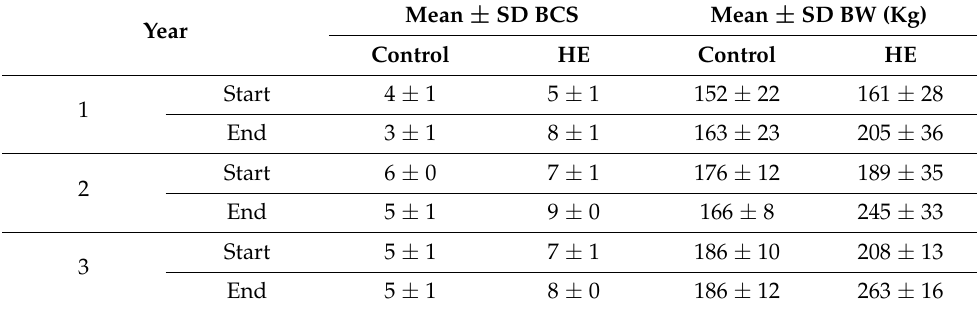
Table 1. Mean ± SD body condition score (BCS) and body weight (BW) for the control and high- energy (HE) groups for the start and end of each diet year (years 1–3).